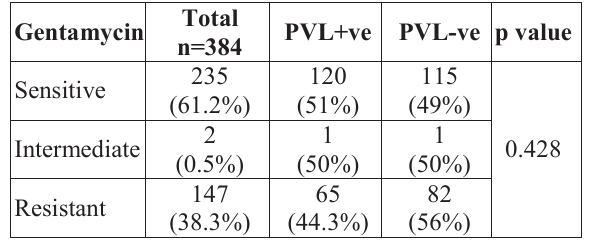
Table-3: Penton Valentine Leukocidin gene and Gentamycin